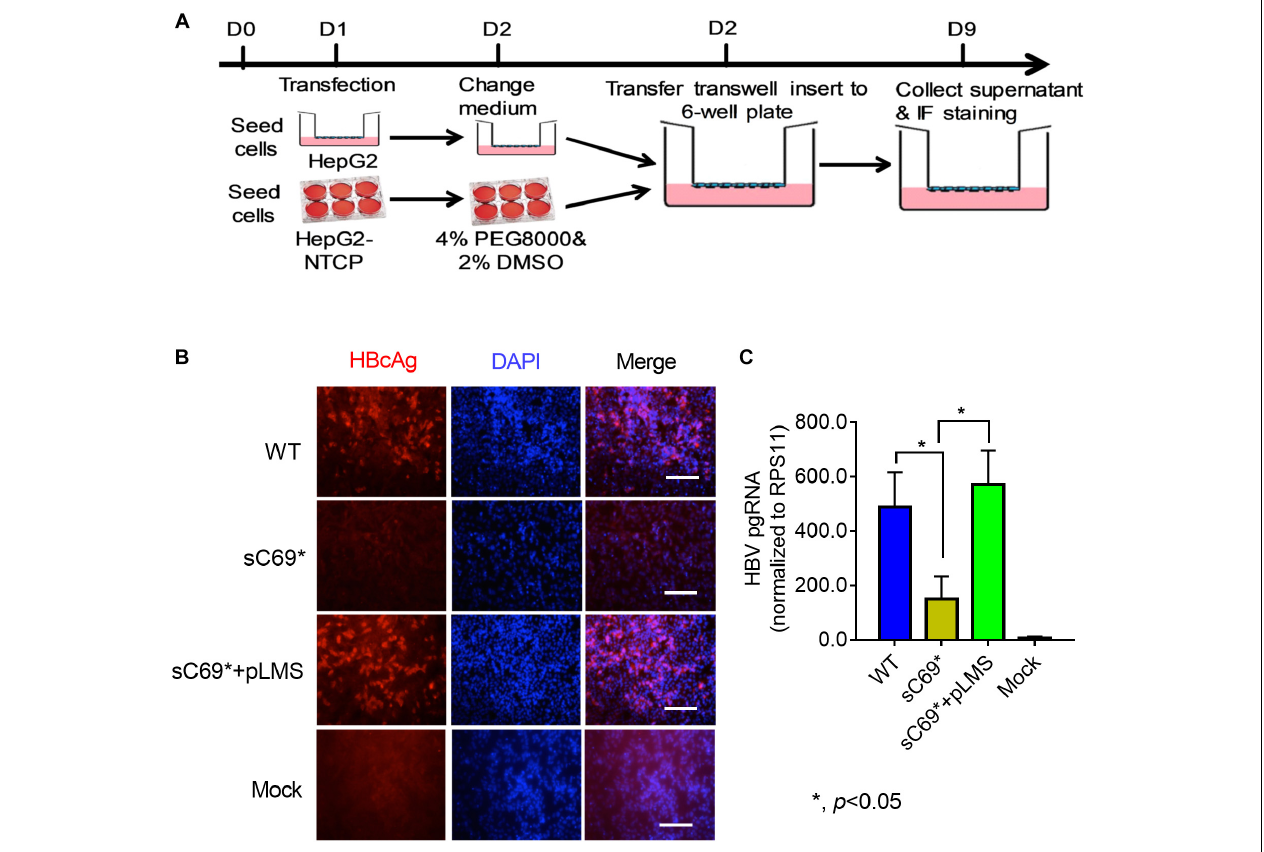
FIGURE 1 | The viral infectivity affected by sC69 ∗ substitution could be rescued when co-existence with wild-type (WT) HBsAg. (A) The schematic strategy was used to test HBV infectivity in the trans -well system. To avoid the impact of collecting and concentrating steps on viral activity, we tried to use the trans -well system to test HBV infection. HepG2 cells seeded in the insert of trans -well were transfected with HBV WT, sC69 ∗ and sC69 ∗ + pLMS, respectively. The next day, the inserts were transferred to wells with HepG2-NTCP cells. Seven days post-infection, HBV related marker were detected. (B) Immunofluorescent microscopy of HBcAg in the WT, sC69 ∗ and sC69 ∗ + pLMS infection, scale bars: 100 µ m. (C) RT-qPCR detection of HBV pgRNA at different groups. Data from three biological replicates are shown as means ± s.d. Statistical analysis was performed by a Student’s t -test ∗ p <